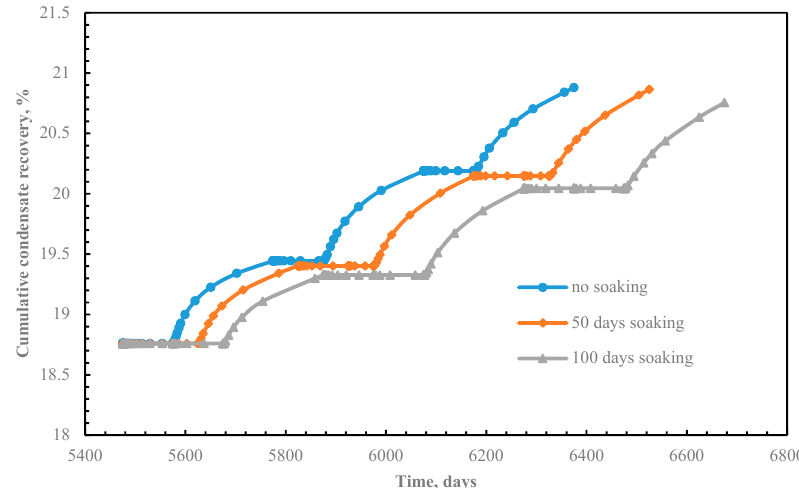
Energies 2018 , 11 , x FOR PEER REVIEW Figure 17. Cumulative condensate recovery for different soaking at 3000 injection pressure.